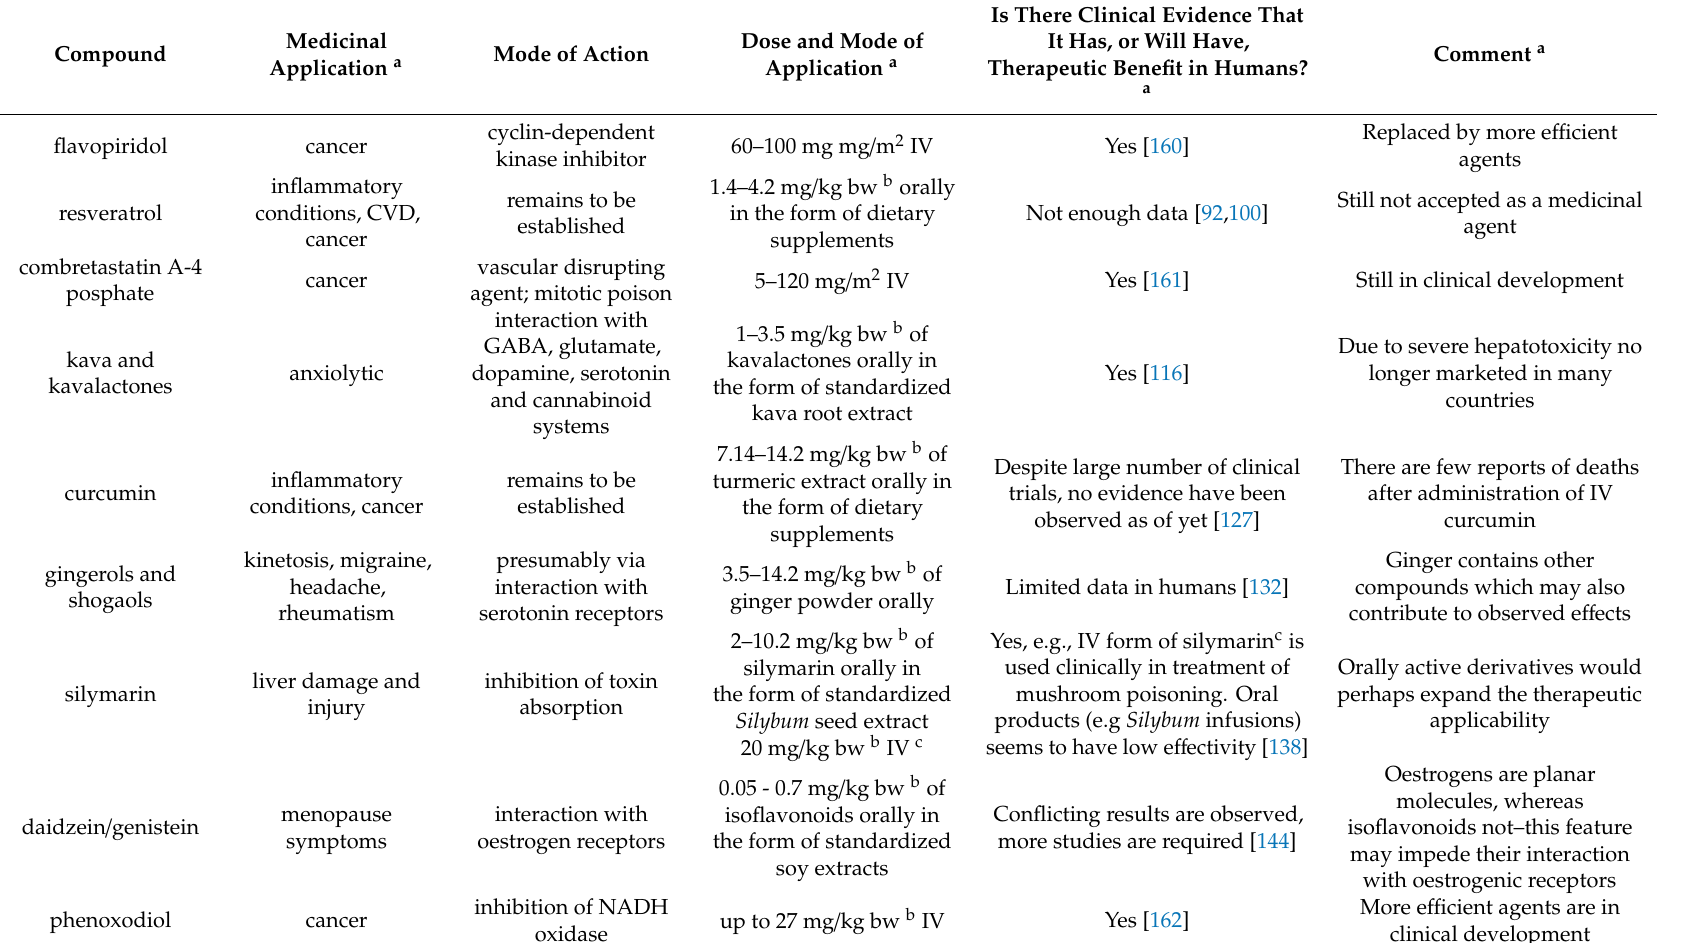
Table 4. The roles of aromatic polyketides with limited distribution in human